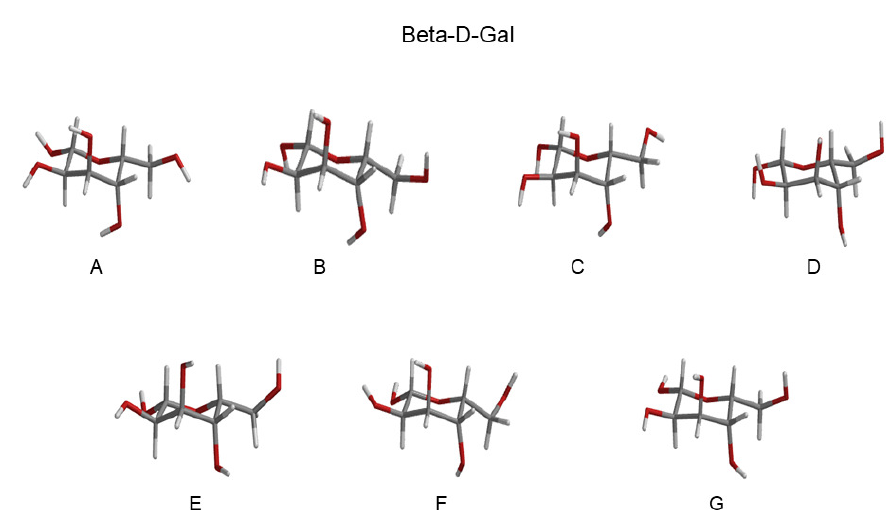
Figure 14. Schematic view of the Beta-Gal RCs extracted from the basins, as reported in Figure 12. Additional details can be found in the Supplementary Materials. Table 2. Probability of the conformations (from A to G) corresponding to the RCs, as obtained by the MD-free for Alpha-Gal and Beta-Gal. The rotamer involved in each conformation is indicated in parentheses.